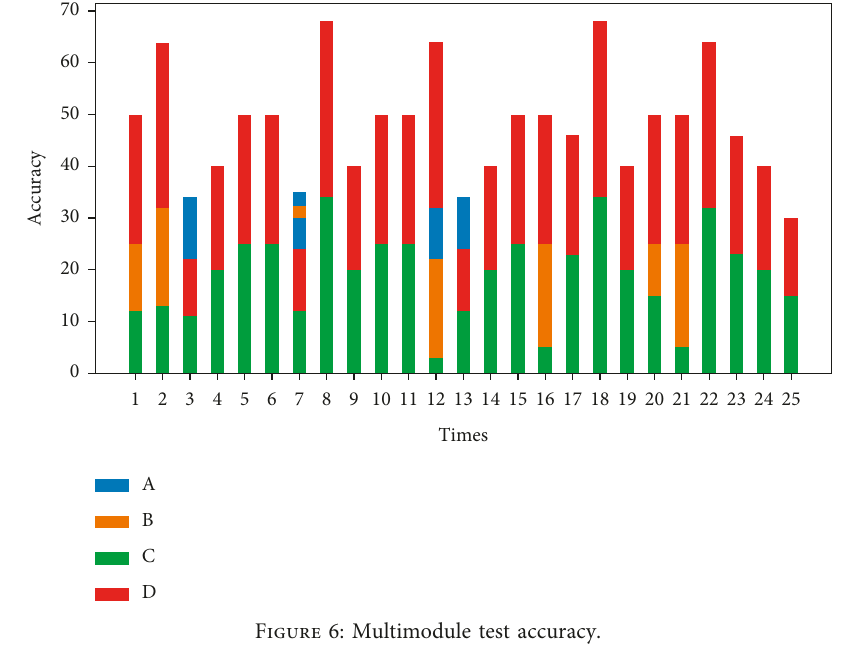
Figure 6: Multimodule test accuracy.